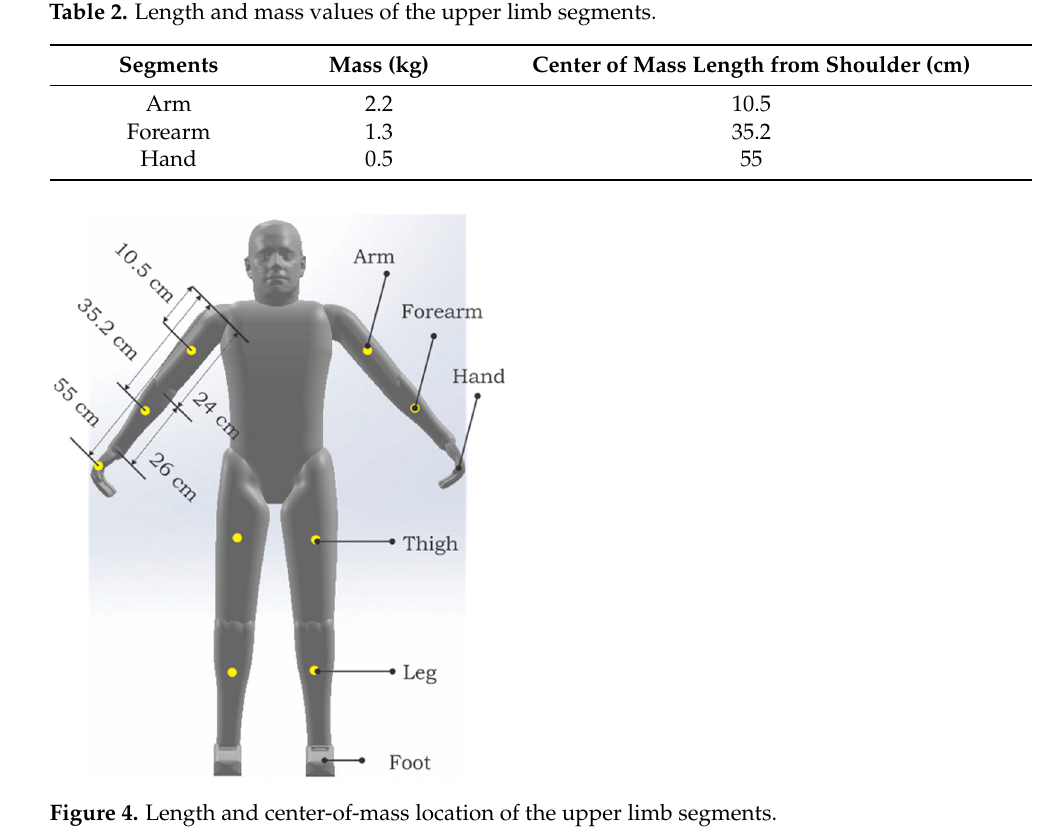
Figure 6. CAD view showing the architecture of the 3 ‐ DOF upper limb rehabilitation exoskeleton considering segment weights. 4.1. Results with the PID Type Controller The exoskeleton response with the PID controller (4) with trajectory tracking to achieve a 90° bending movement in 5 s is shown in Figure 7. The Bézier polynomial Equa ‐ tion (17) was used to achieve a smooth movement, as shown for the angle 𝜃 (cid:2870) . It is im ‐ portant to mention that in this simulation, the weight derived from the limb of the patient to be rehabilitated was not considered, only the inertia of the links. It is observed that there is a control effort in all the links to keep the exoskeleton in a flexed position.